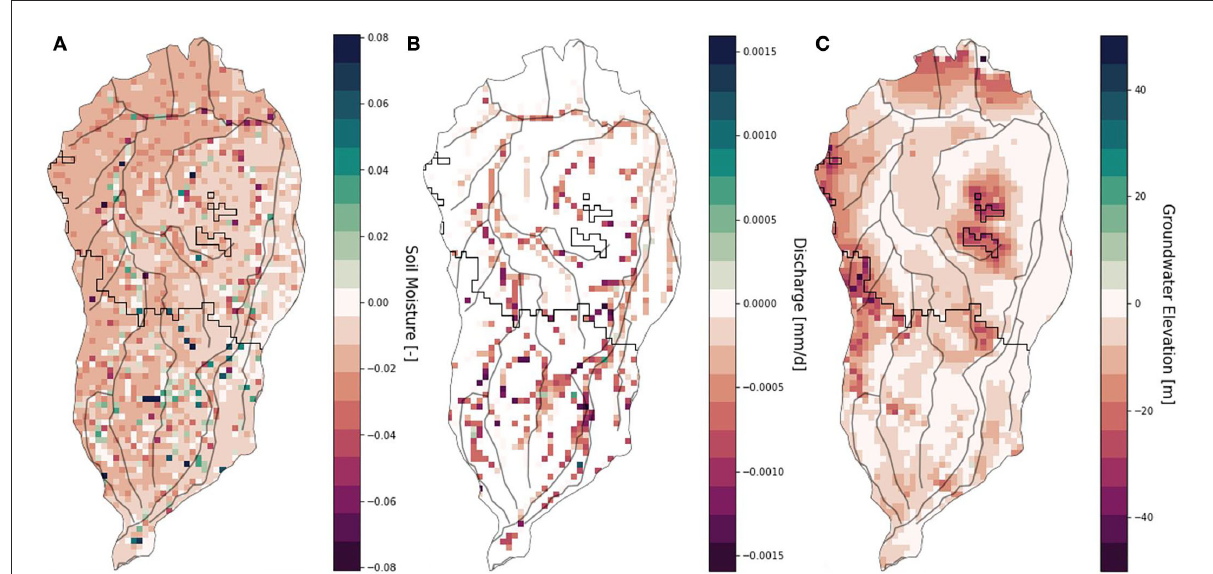
FIGURE7 Soil moisture (A) , discharge (B) and groundwater elevation (C) in the 2010 OND rainy season, compared to the average of the seasons before (2005–2009). The river network in the figure (gray lines) is for orientation purposes only, see Supplementary material for the modeled river network.